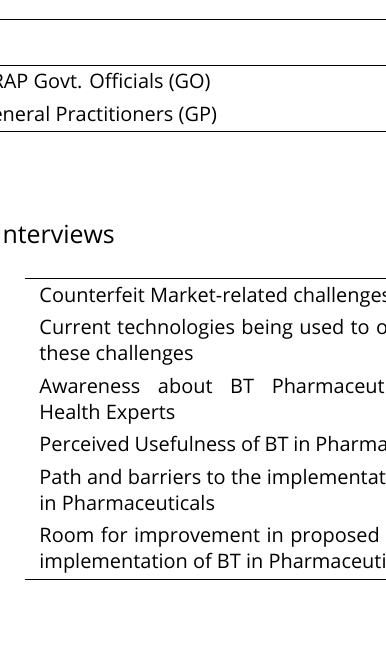
Characteristics of